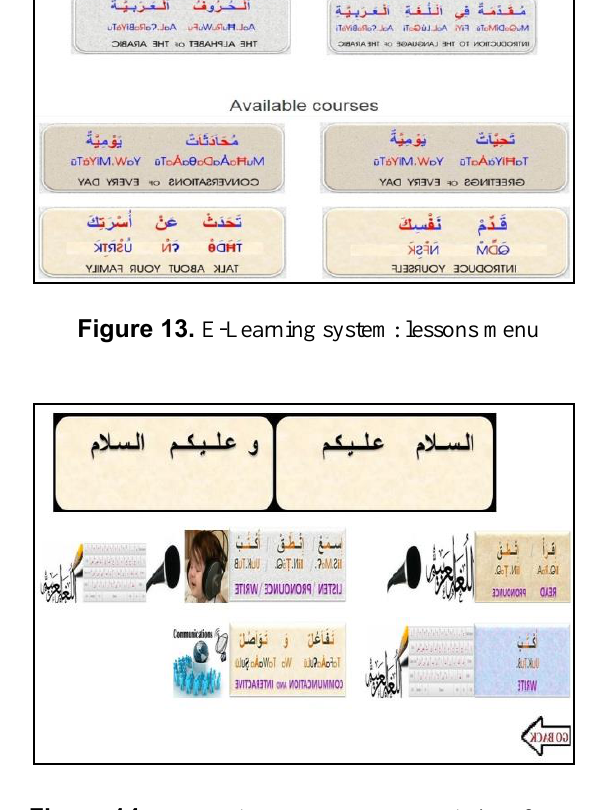
Figure 14. E-Learning system: Lesson window format